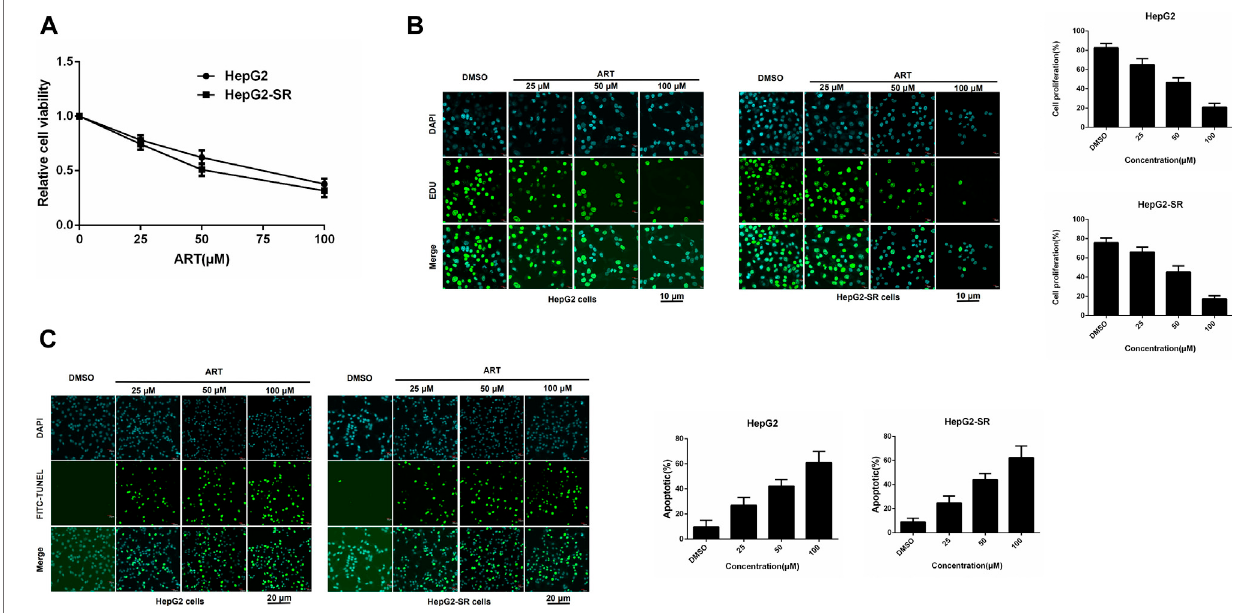
FIGURE 1 | Artesunate (ART) can effectively inhibit the propagation of sorafenib-resistant cells. (A) . HepG2-SR cells were treated with 0, 25, 50, or 100 μ m artesunate,and48 hlaterMTTassayswereperformedtodetectartesunatesensitivityinthecells. (B) .CellpropagationdetectedbyEDUassays.Cellswerestainedwith DAPI (blue) for visualization of nuclei, and EDU (green) signi fi es proliferative cells. EDU-positive cells per fi eld were quanti fi ed in multiple fi elds, and cell proliferation was measured relative to total cells. Scale bars (cid:2) 10 μ m. (C) . Apoptosis detected via FITC-TUNEL staining assays. Blue (DAPI) represents nuclei, and green (FITC- TUNEL) represents apoptotic cells. FITC-TUNEL-positive cells per fi eld were quanti fi ed in multiple fi elds and the ratio of apoptotic cells was measured relative to total cells. Scale bars (cid:2) 20 μ m. Experiments were repeated three times.